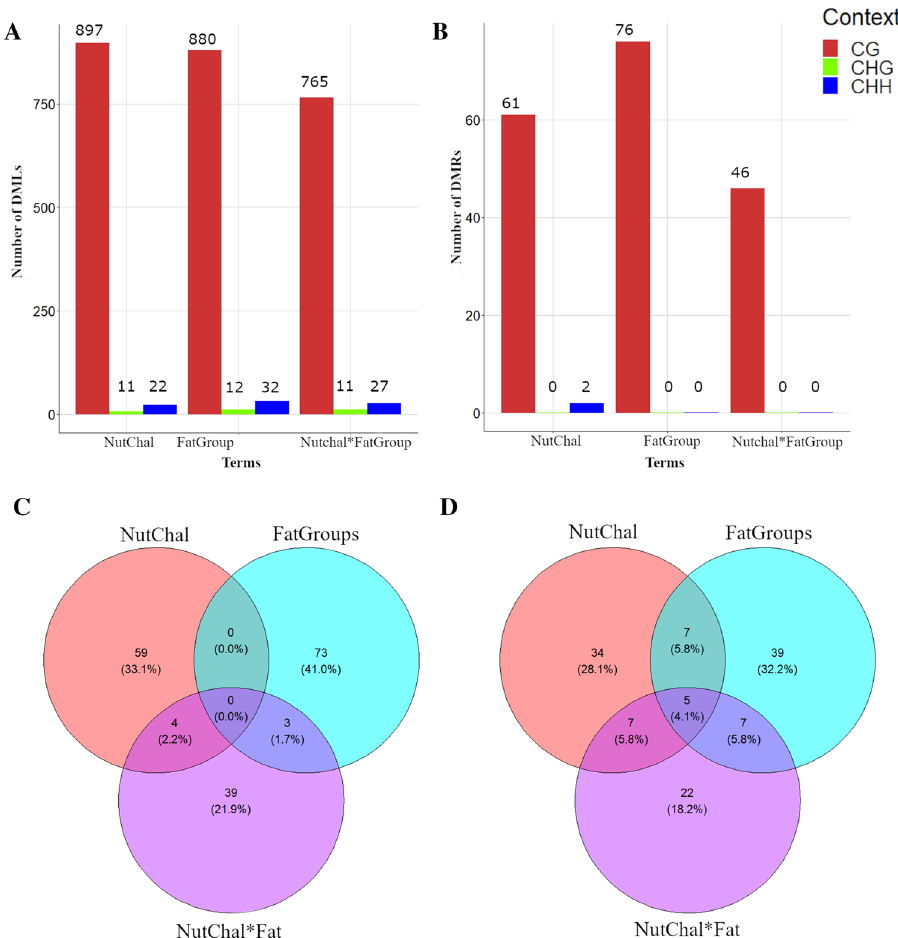
Figure 1. Bar plot showing the number of differentially methylated loci ( A ) and regions ( B ) identified in each nucleotide context (CG in red, CHG in green and CHH in blue) for the three terms evaluated in the multifactorial model (NuChal, FatGroup and NutChal * FatGroup). Venn diagram showing the number of differentially methylated regions ( C ) and genes harboring differentially methylated regions ( D ) among NuChal (ref), FatGroup (blue) and NutChal * FatGroup